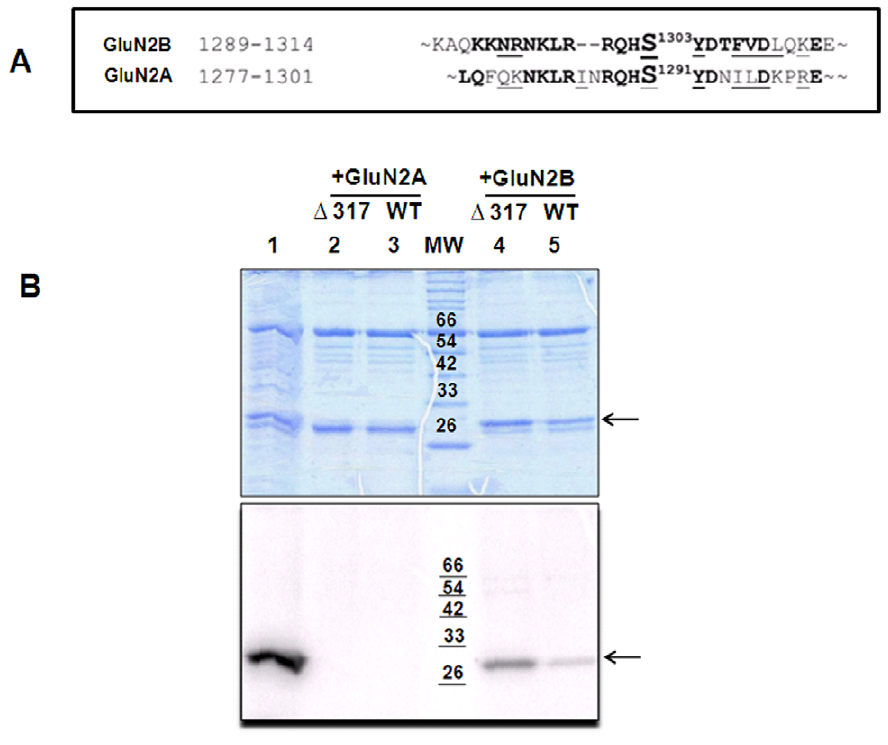
Figure 1. Monomeric CaMKII can bind to GluN2B sequence. A: Sequence alignment of GluN2A and GluN2B. The sequence motifs of GluN2A and GluN2B used for the study are aligned. The conserved residues are underlined with black lines and identical residues are shown in bold. The phosphorylatable residues are shown in a larger font. B: GST-pull down assay followed by phosphorylation shows that monomeric CaMKII binds to GST-GluN2B. GST-pull down assay was done with crude cell lysates of fusion proteins and monomeric CaMKII. Since western blotting could not detect the pulled down monomeric enzyme, we resorted to utilizing the calcium independent activity of the GluN2B bound CaMKII for detection. Upper panel shows the SDS-PAGE and lower panel shows the autoradiogram of the gel. Molecular weight marker positions in the autoradiogram are indicated with black lines. Phosphorylation has happened only in the reactions that have pulled down CaMKII. Arrow mark shows the position of GST-GluN2B. Lane 1: phosphorylation of GST-GluN2B (1271–1311) by WT- a -CaMKII before pull down; lanes 2 and 3: phosphorylation after pull down performed as negative control using GST-GluN2A (1265–1301) for D 317- a -CaMKII and WT- a -CaMKII respectively; lane MW: Molecular weight marker. Molecular weights are indicated in kDa. Lanes 4 and 5: phosphorylation after pull down using GST-GluN2B (1271– 1311) of D 317- a -CaMKII and WT- a -CaMKII respectively. Data represents 2 experiments.